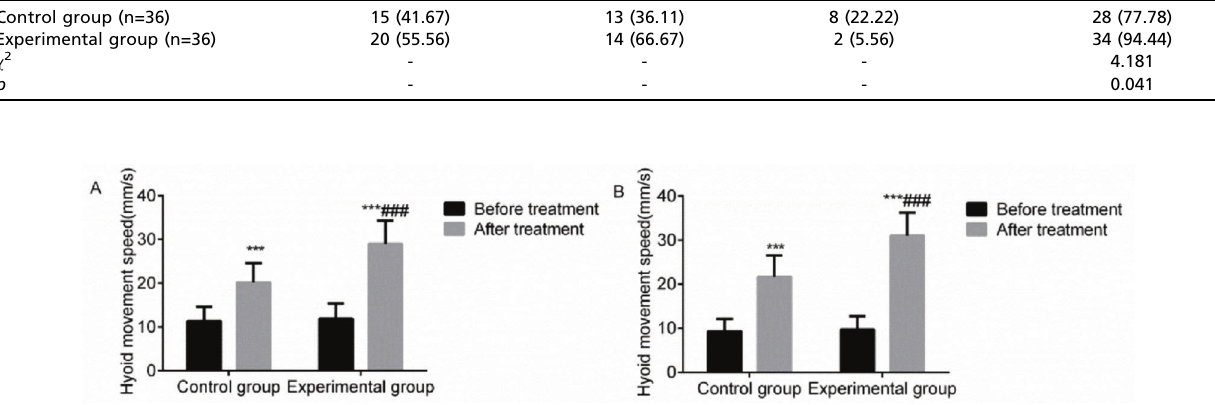
Figure 1 - Comparison of the upward and forward movement speeds of the hyoid bone between the two groups before and after treatment. Note: compared with the group before treatment, *** p o 0.001; compared with the control group, ### p o 0.001.